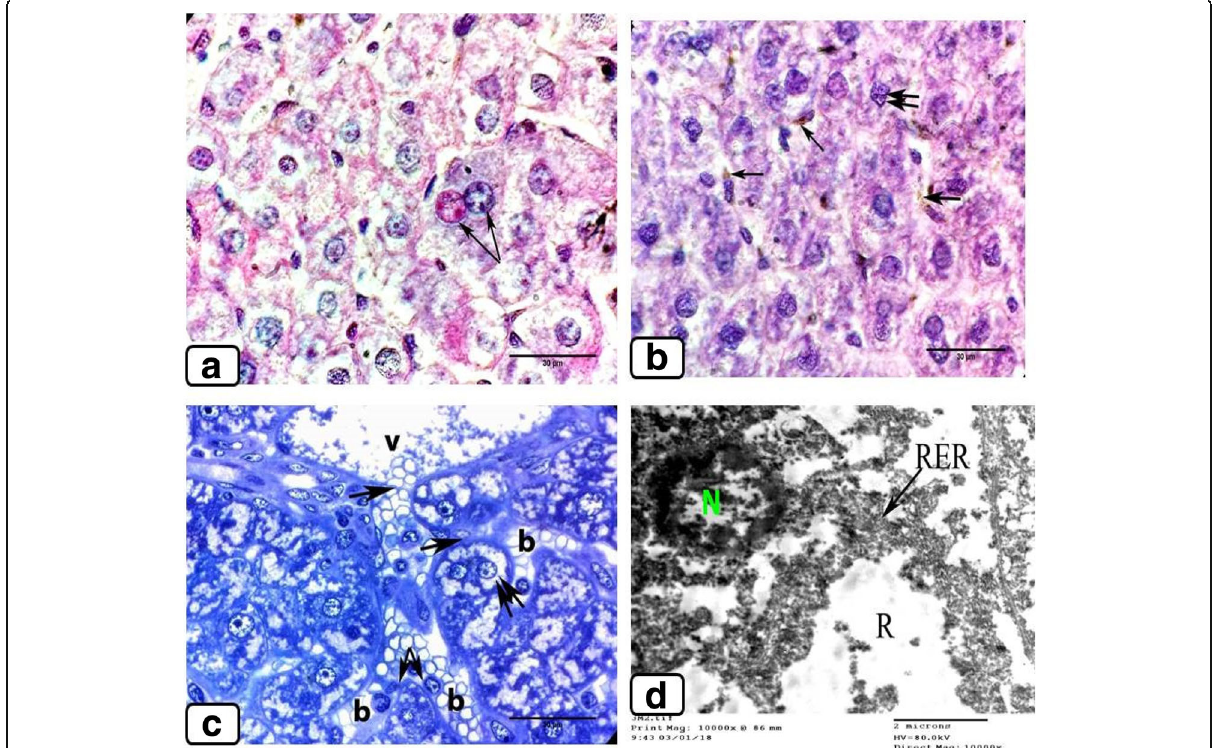
Fig. 7 M4 group liver showing a binucleated hepatocytes were dissimilar in their color stain ( ↑↑ ) and most of the hepatocytes devoid completely from the cytoplasm (H&E). b Yellow-brown color of lipofuscin pigments in many of Kupffer cells ( ↑ ) and the nuclei of some hepatocytes appeared irregular in its shape ( ↑↑ ) (H&E). c Damage of the wall of both blood vessels (V) and blood sinusoids (b) and fusion of their congested lumen ( ↑ ) and most hepatocytes with extensive vacuolar degeneration ( ↑↑ ) (toluidine blue stain). d Ultrastructurally of hepatocyte showing remaining of fragment RER ( ↑↑ ) rarified cytoplasmic space (R) and degenerated nucleus